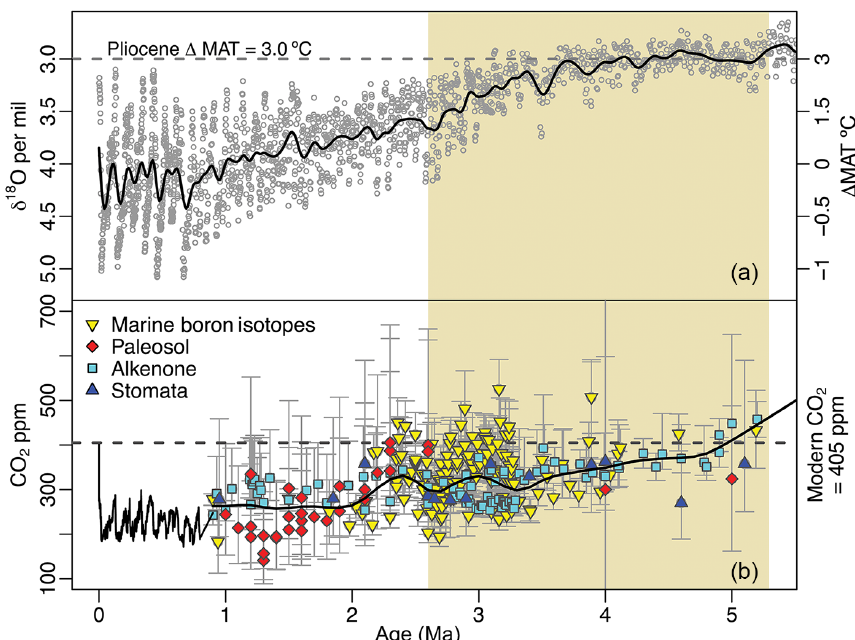
Figure 1. Global temperatures and atmospheric CO 2 concentration spanning the last 5million years of Earth’s history. Mean annual tem- peratures (MATs) are inferred from compiled δ 18 O foraminifera data (Lisiecki and Raymo, 2005) and plotted as anomalies from present values (a) . Modern atmospheric CO 2 measurements (NOAA/ESRL) and ice core observations from EPICA (Luthi et al., 2008) are compared with proxy estimates ( b ; see Table S1) for the Pliocene epoch, indicated with beige shading. Smoothed curves have been fit to highlight trends in p CO 2 and temperature during the